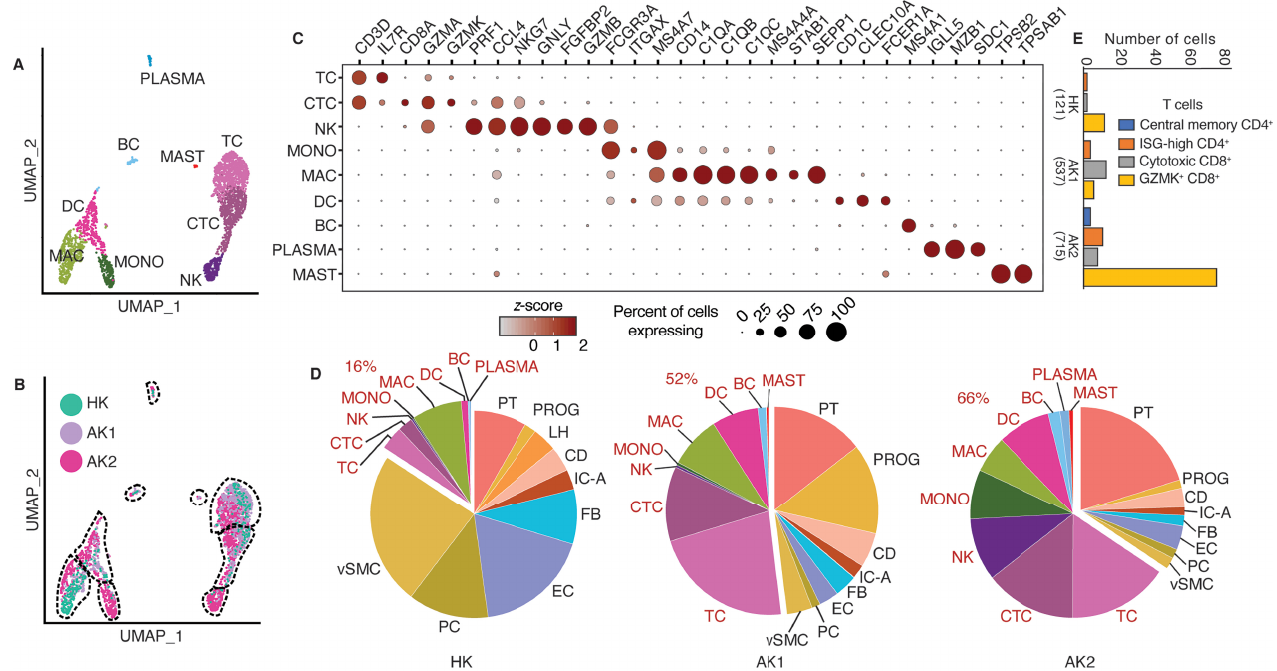
Fig 14. Immune cell heterogeneity in the healthy and allograft kidneys. (A). UMAP-based visualization of immune cells colored by different cell types. TC, T lymphocytes; CTC, cytotoxic T lymphocytes; NK, natural killer cells; MONO, monocytes; MAC, macrophages; DC, dendritic cells; BC, B lymphocytes; PLASMA, plasmablast cells. (B). UMAP-based visualization of immune cells colored by the biopsies HK, AK1 and AK2. (C). Dot-plot showing expression of known lineage gene markers. (D). Pie chart depicting the proportion of cell types in each biopsy sample. The immune cells are labelled in red. (E). Bar graphs showing the different types of T cells in HK, AK1, and AK2. Central memory CD4 + T cells: CCR7 + SELL + TCF7 + ; ISG-high CD4 + T cells: CD4 + ISG15 + ; Cytotoxic CD8 + T cells: CD8A + GZMB +